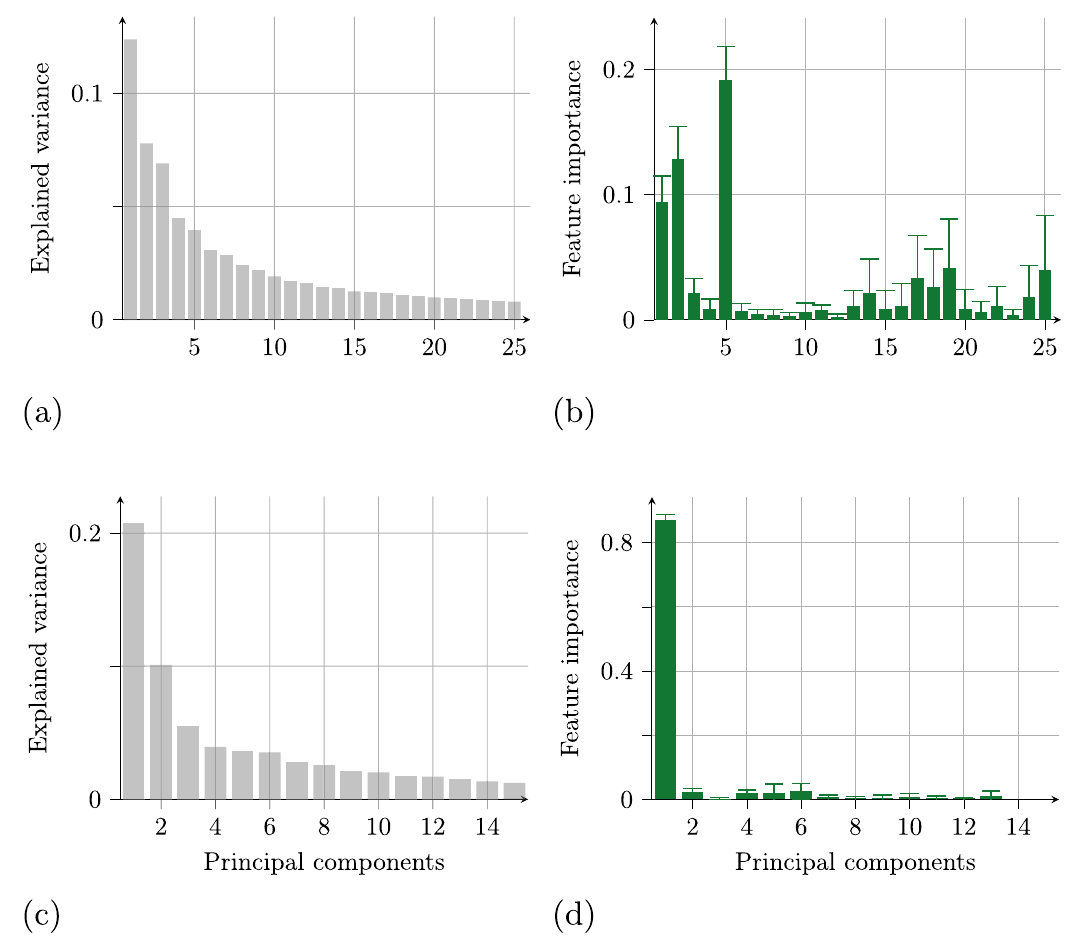
Fig. 5 Explained variance and feature importance. Visualization of different parameters for the 25 most principal components ranked in descending order by the explained variance for the ( a ) criteria-based and ( c ) empirical approaches, and ( b ) and ( d ) the mean gradient boosting coef fi cients during 5 × 5 cross-validation with the standard deviation (s.d.) for the corresponding approaches as error bars. Note that in ( a ) and ( b ) only the results of the PCA analysis are visualized, while ( c ) and ( d ) contains results of the PCA reduced training sets using gradient boosting 19,70 . The latter shows that for the empirical approach most of the physics is represented by a few features. The results in ( b ) and ( d ) are similar to those obtained with logistic regression, decision trees and random